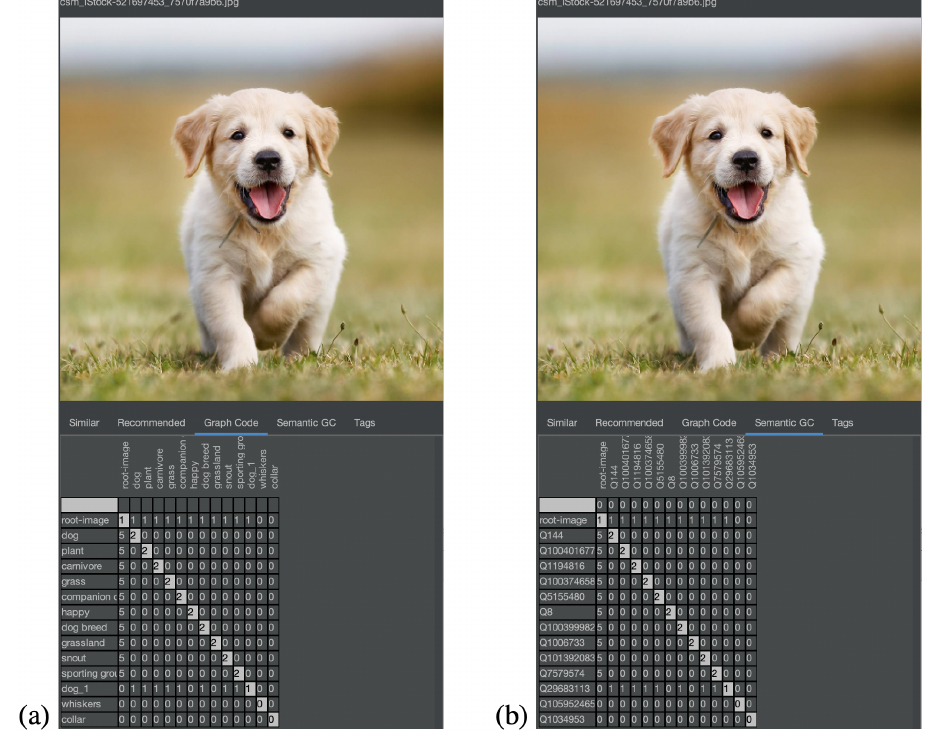
Figure 12. GMAF-UI displaying image: ( a ) Graph Codes ; ( b ) the corresponding Semantic Graph Code